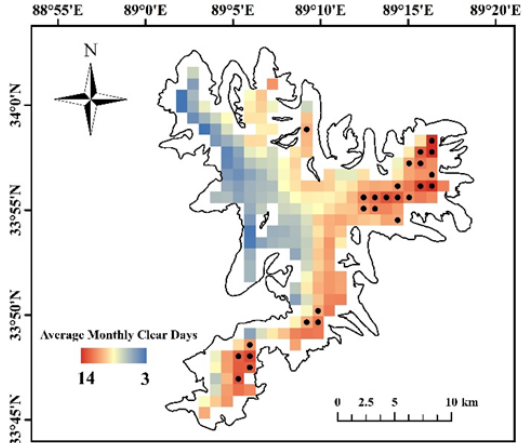
Figure 9. Average number of clear days per winter month (December, January, and February) from 2001 to 2018. The black dots indicate the 26 pixels that were selected to calculate the LST (land surface temperature) trends for all three winter months.